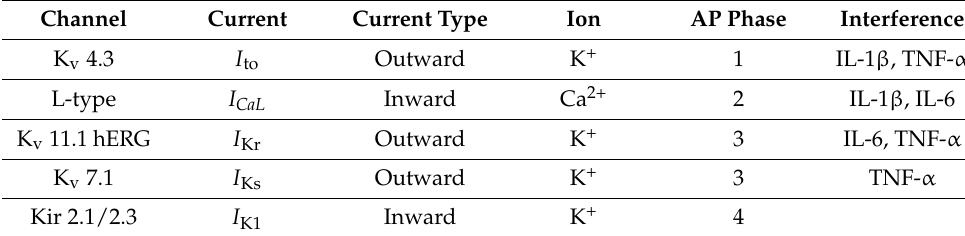
Table 1. Kv 4.3, Kv 11.1 or hERG, and Kv 7.1 are voltage-gated potassium